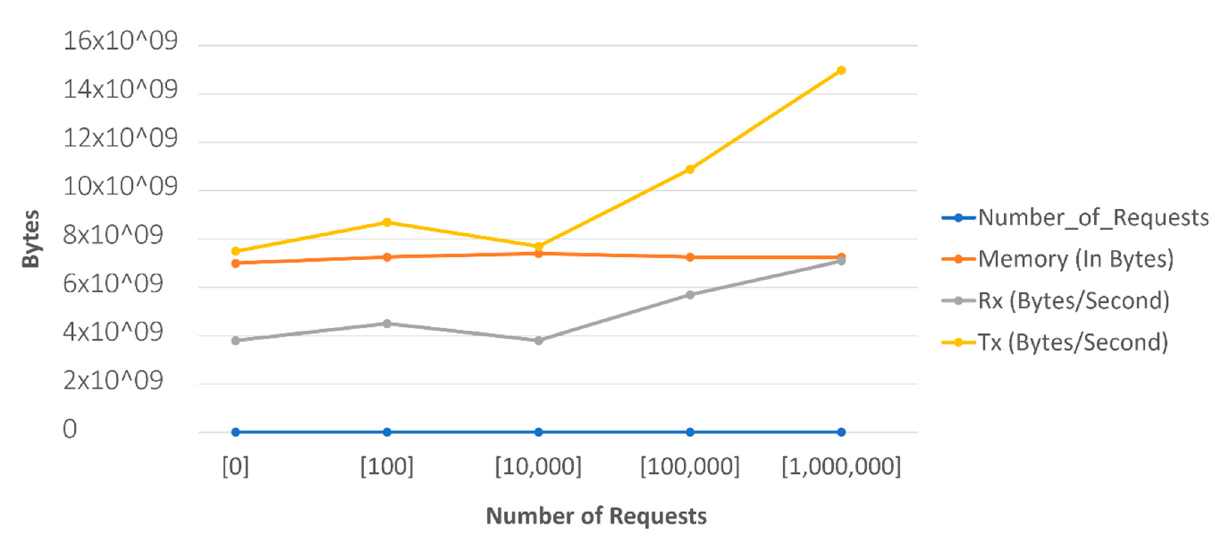
Figure 24. Performance of the scaled system by 3 nodes: memory and transmissions (Rx, and Tx).